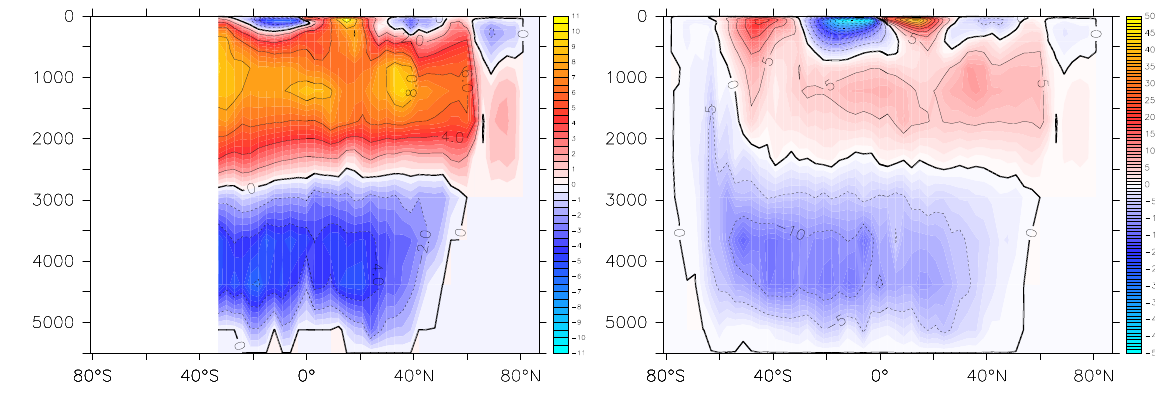
Fig. 9. The ensemble mean Atlantic (left) and global (right) meridional overturning circulation in Sv in SPEEDO.